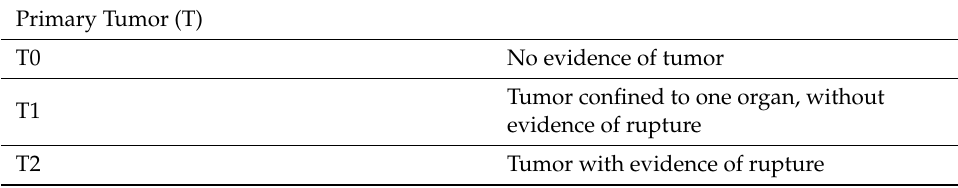
Table 5. Simplified clinical staging model proposed for canine visceral